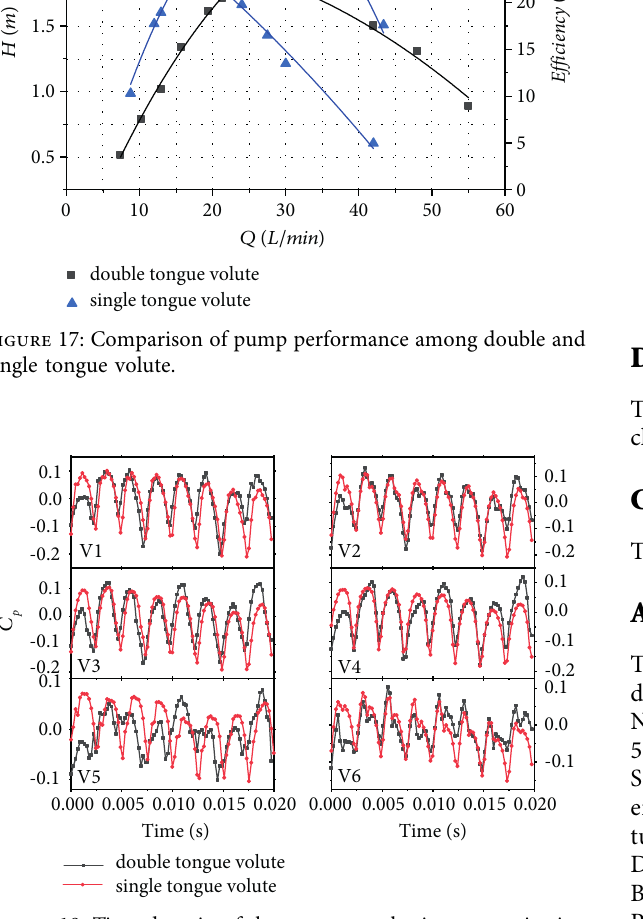
Figure 18: Time domain of the pressure pulsation at monitoring points